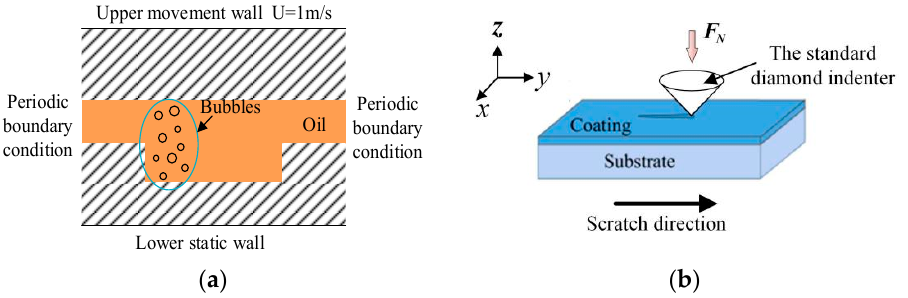
Figure 13. Gas and coating assisting drag reduction: ( a ) drag reduction coupling with solid, liquid, and gas; ( b ) TiN coating enhances texture abrasion resistance [40].